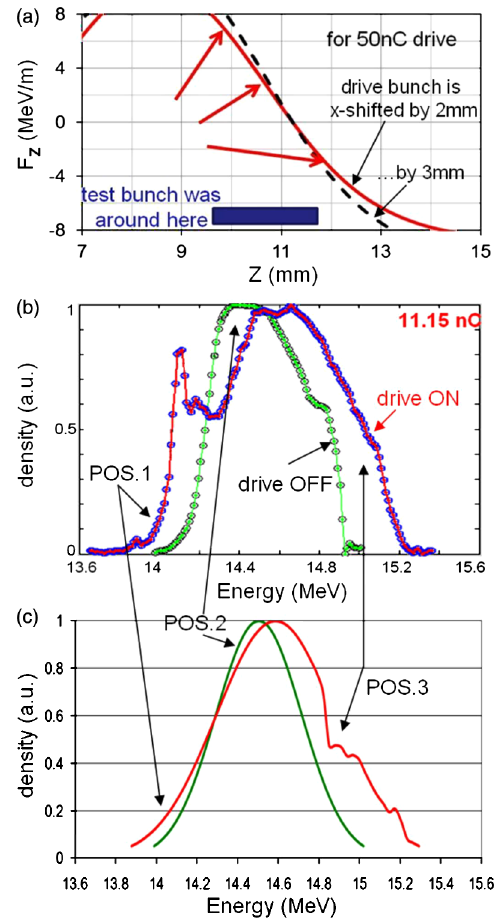
FIG. 14. Simulations of F z for the test channel [values are renormalized to 50 nC (see explanations in the text)] for the delay 21.7 mm. (b) Typical energy distribution (observed in 80% of shots; raw intensity data are shown). (c) Simulations to predict changes in the energy distribution (for case #3